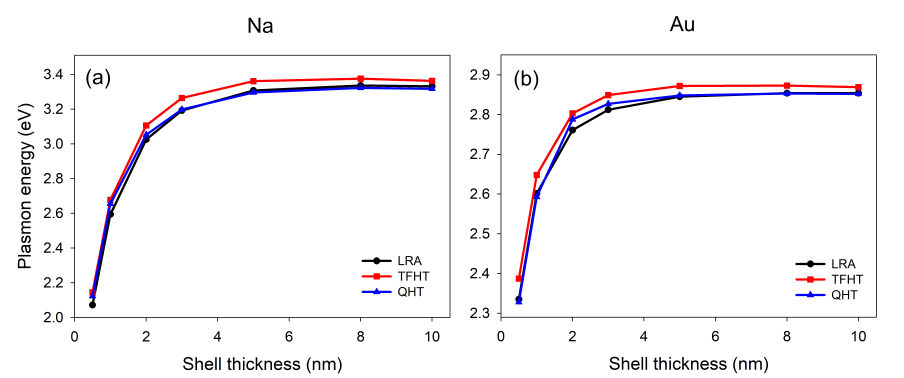
Figure 6. Plasmon energy of LEM for ( a ) Na and ( b ) Au nanoshell as a function of shell thickness t s = R 2 − R 1 and with a fixed core radius R 1 = 2 nm. Results predicted by different methods are presented.